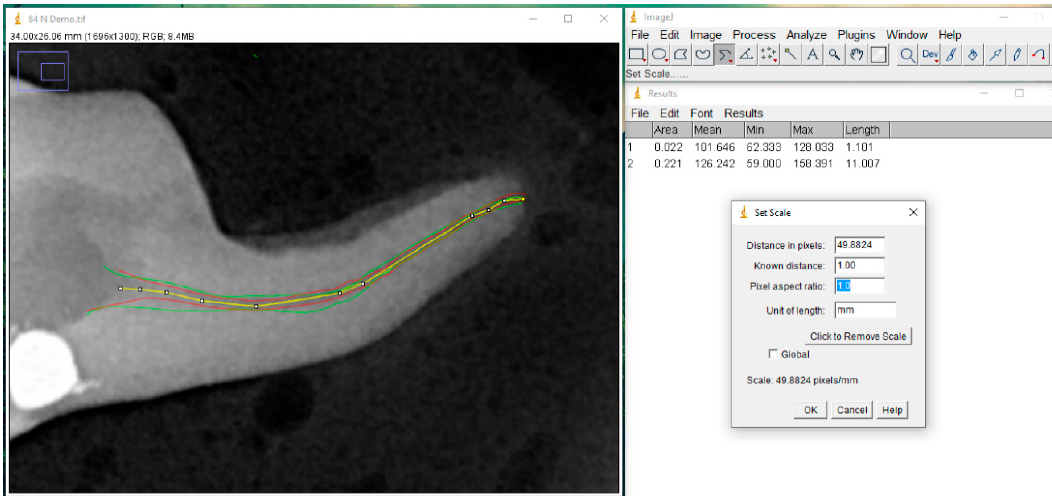
Table 1. Mean bias, confidence intervals, p values in two statistical tests, fixed or proportional bias at each level for the transportations and centering ratios of the two methods’ measurements in the mesio-distal direction. Parameters Levels (mm) Paired t -Test Linear Regression Fixed Bias Proportional Bias Mean Bias